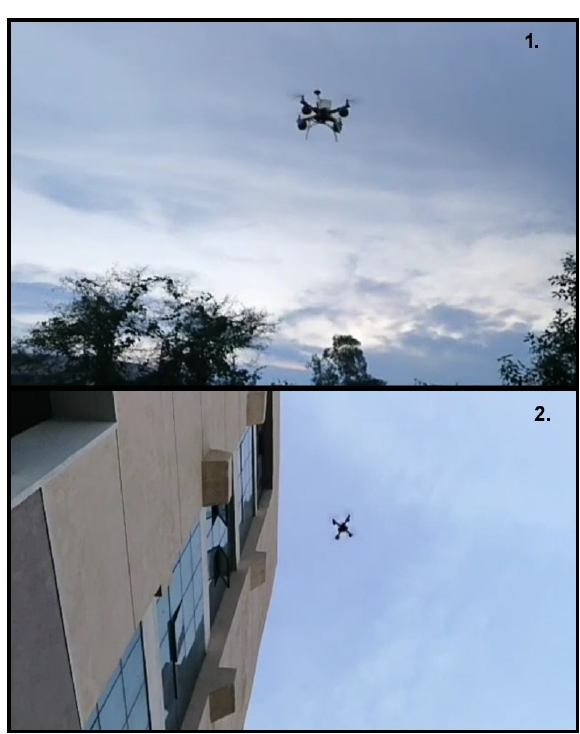
Figure 5. Testing of Unmanned Aerial Vehicle at Fire